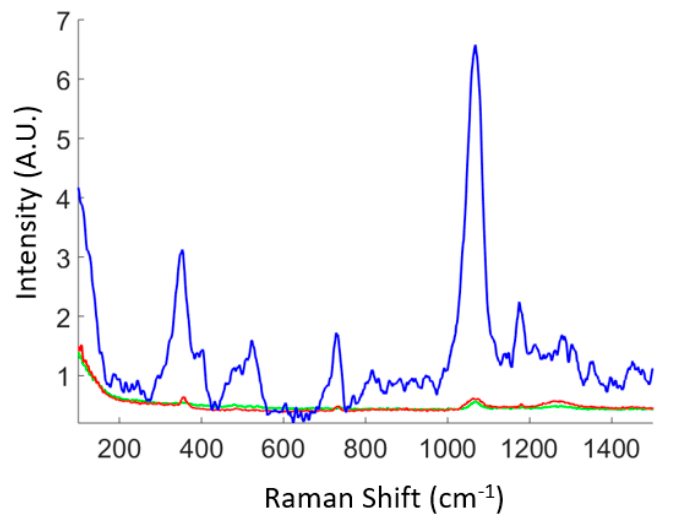
Figure 6. Raman spectra of Benzenedithiol 1,4 chemiosorbed on Au nanowires with large distance (green line), nanowires with middle distance (red), and nanowires with small distance between nanowires (blue line).